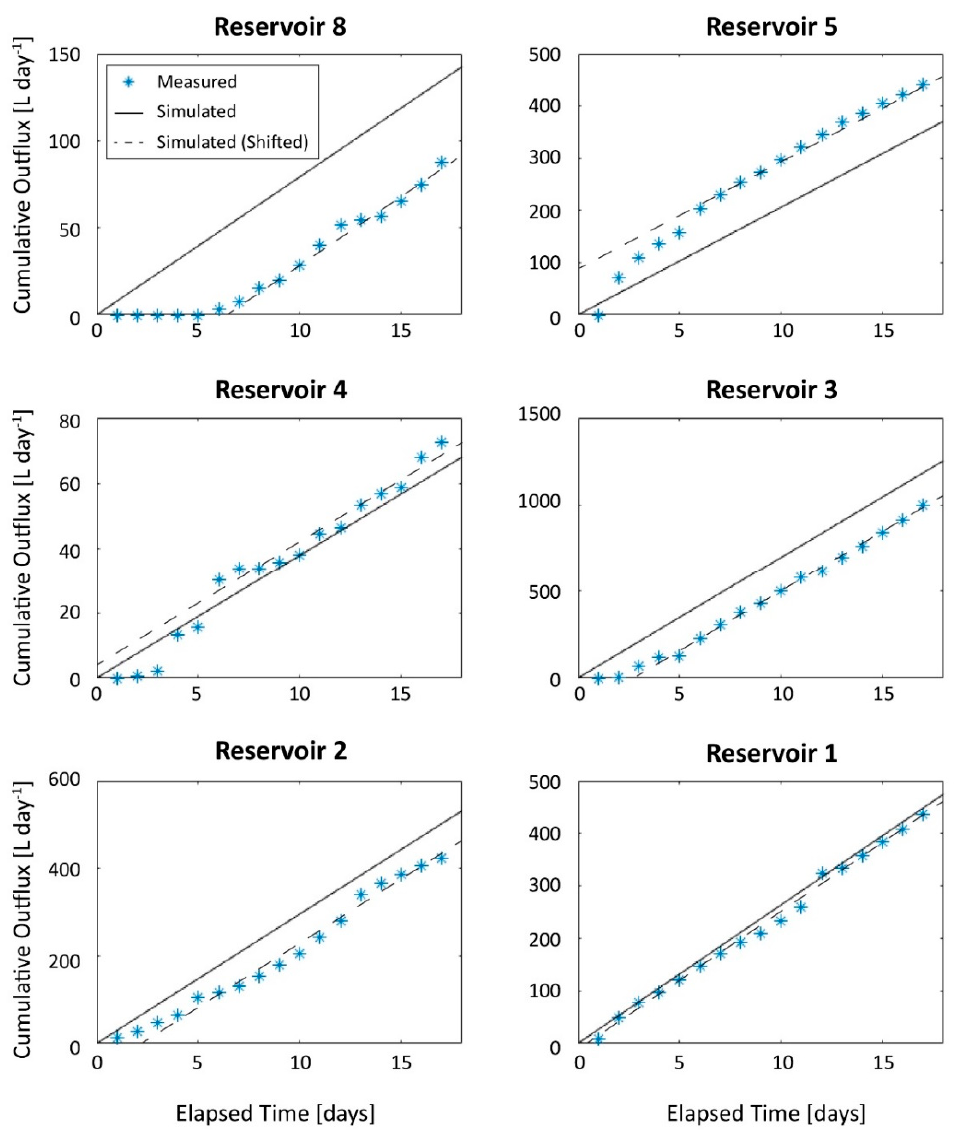
Figure 3. Measured versus simulated cumulative drainage. Blue symbols represent the measured cumulative drainage from the laboratory experiment, while the black lines represent the simulated cumulative drainage obtained from the steady-state flow simulations, calibrated using pressure heads at each reservoir. The dashed lines represent the simulated cumulative drainage shifted to account for the delay of the development of steady-state flow conditions in the physical experiment. The constant slopes at each reservoir indicate that steady-state flow conditions were reached.